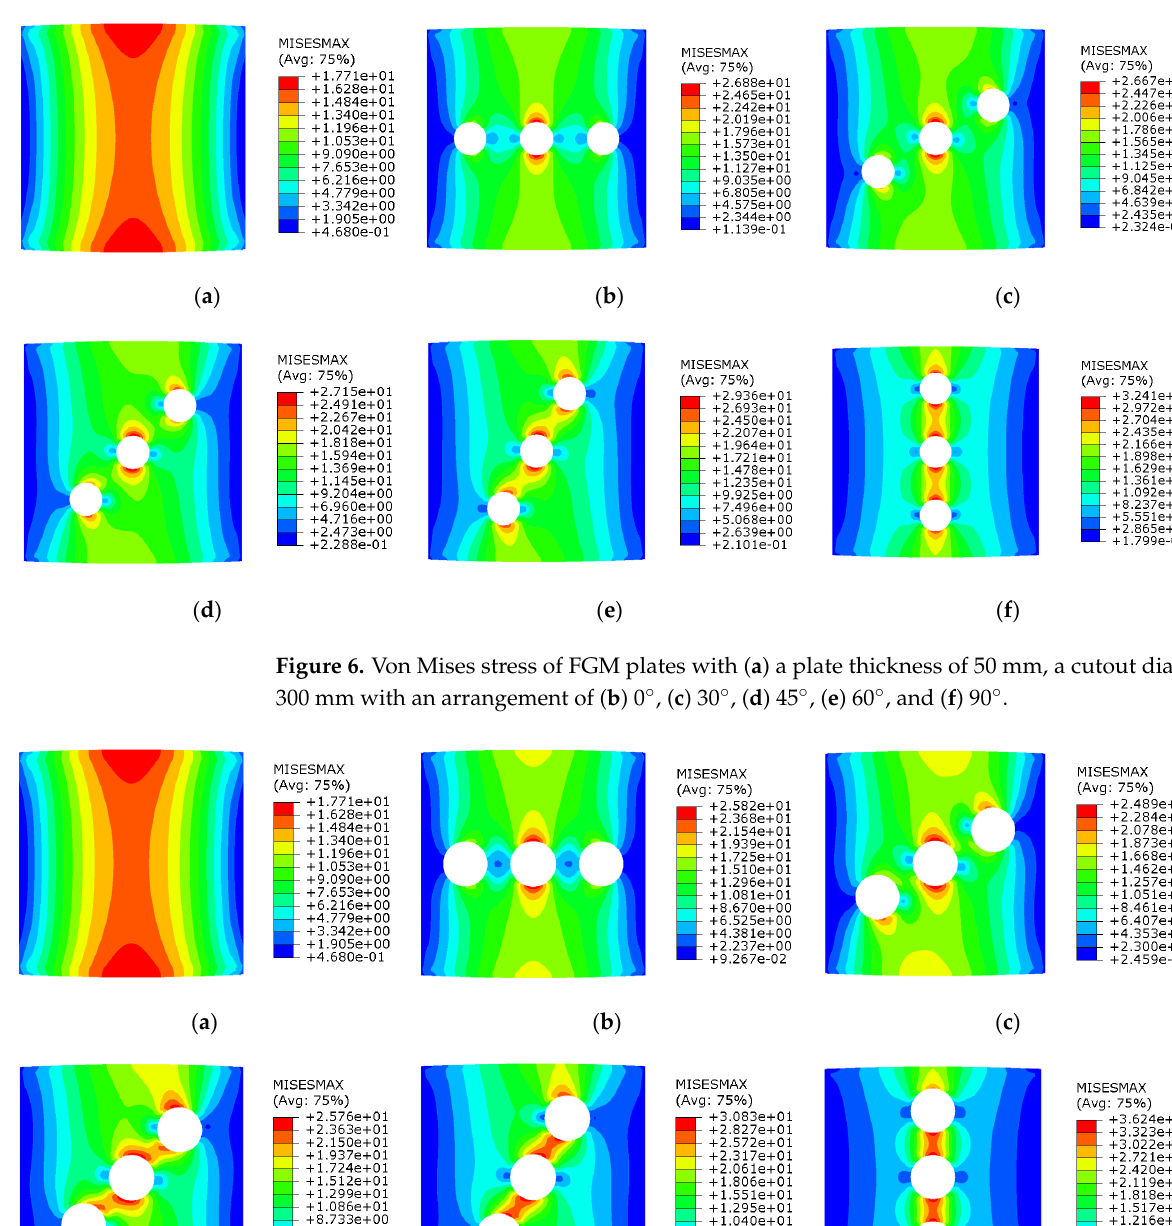
Figure 5 . Von Mises stress of FGM plates with ( a ) a plate thickness of 50 mm, a cutout diameter of 200 mm with an arrangement of ( b ) 0 ° , ( c ) 30 ° , ( d ) 45 ° , ( e ) 60 °, and ( f ) 90 ° . Figure 6 shows the Von Mises stress of FGM plates with various cutouts arrange ‐ ments with a plate thickness of 50 mm and a circular diameter of 300 mm. Whereas, Figure 7 shows the Von Mises stress of FGM plates with various cutouts arrangements with a plate thickness and circular diameter of 50 mm and 400 mm, respectively.